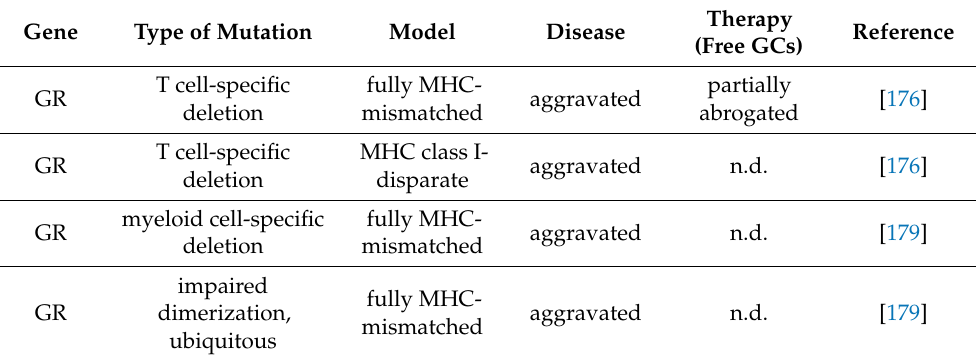
Table 5. Phenotype of selected genetic mouse models of GvHD. Fully MHC-mismatched